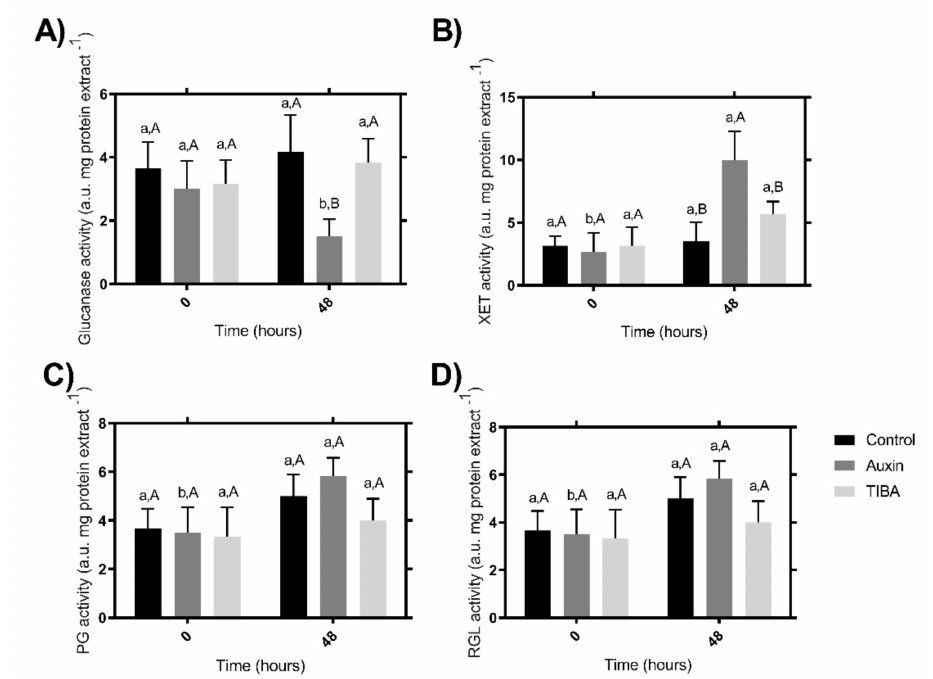
Figure 5. Patterns of total enzyme activities. Total glucanase/cellulase activity ( A ); total xyloglucan endotransglucosidase (XET) activity ( B ); total polygalacturonase (PG) activity ( C ); and total rhamnogalacturonan endolyase (RGL) activity ( D ). The enzymatic activities assayed during fruit treatments at 0 or 48 h post-treatment. Different letters indicate significant differences between cultivars and stages ( p < 0.05